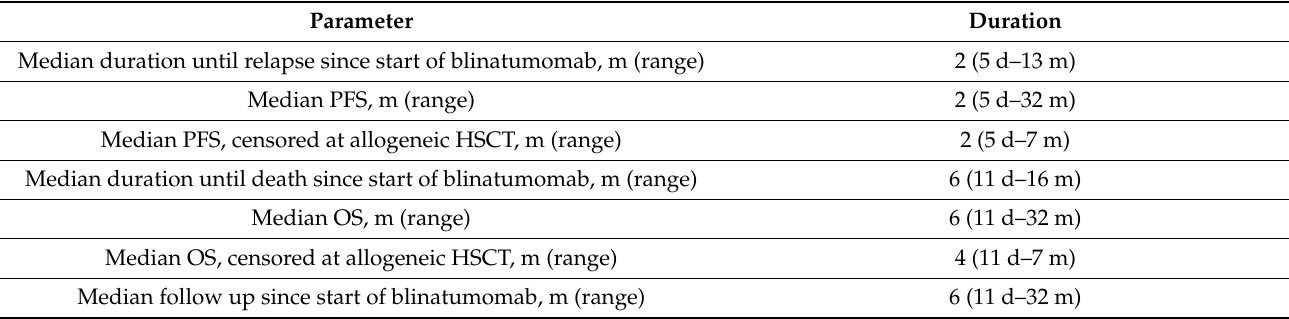
Figure 2. ( A ) Progression-free survival and ( B ) overall survival since the start of blinatumomab therapy, censored at allogeneic hematopoietic stem cell transplantation (months).